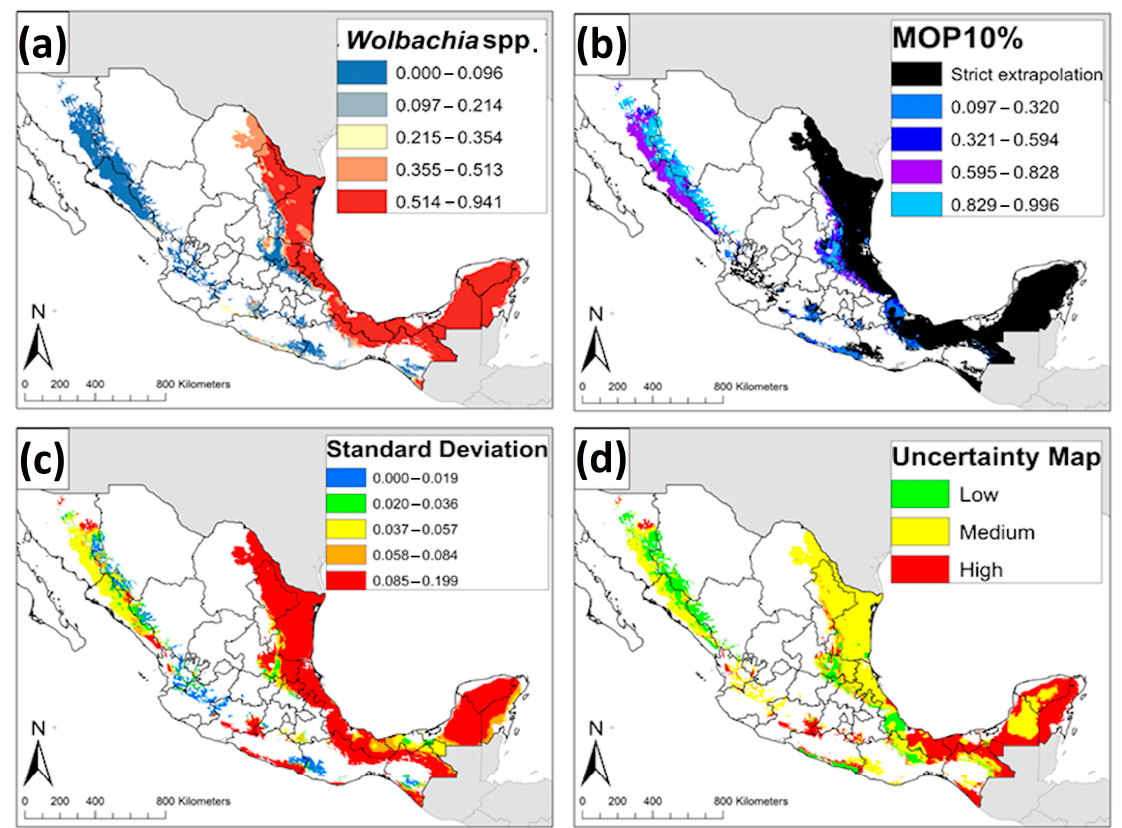
Figure 6. Ecological niche model and uncertainty maps of natural Wolbachia infections in the host Aedes albopictus in México . ( a ) Ecological niche model of natural Wolbachia infections in México. ( b ) Extrapolation risk in projecting the Wolbachia model from the calibration area to a projection area (mobility-oriented parity (MOP) 10%). ( c ) Standard deviation map; ( d ) Uncertainty map of Wolbachia prediction model.